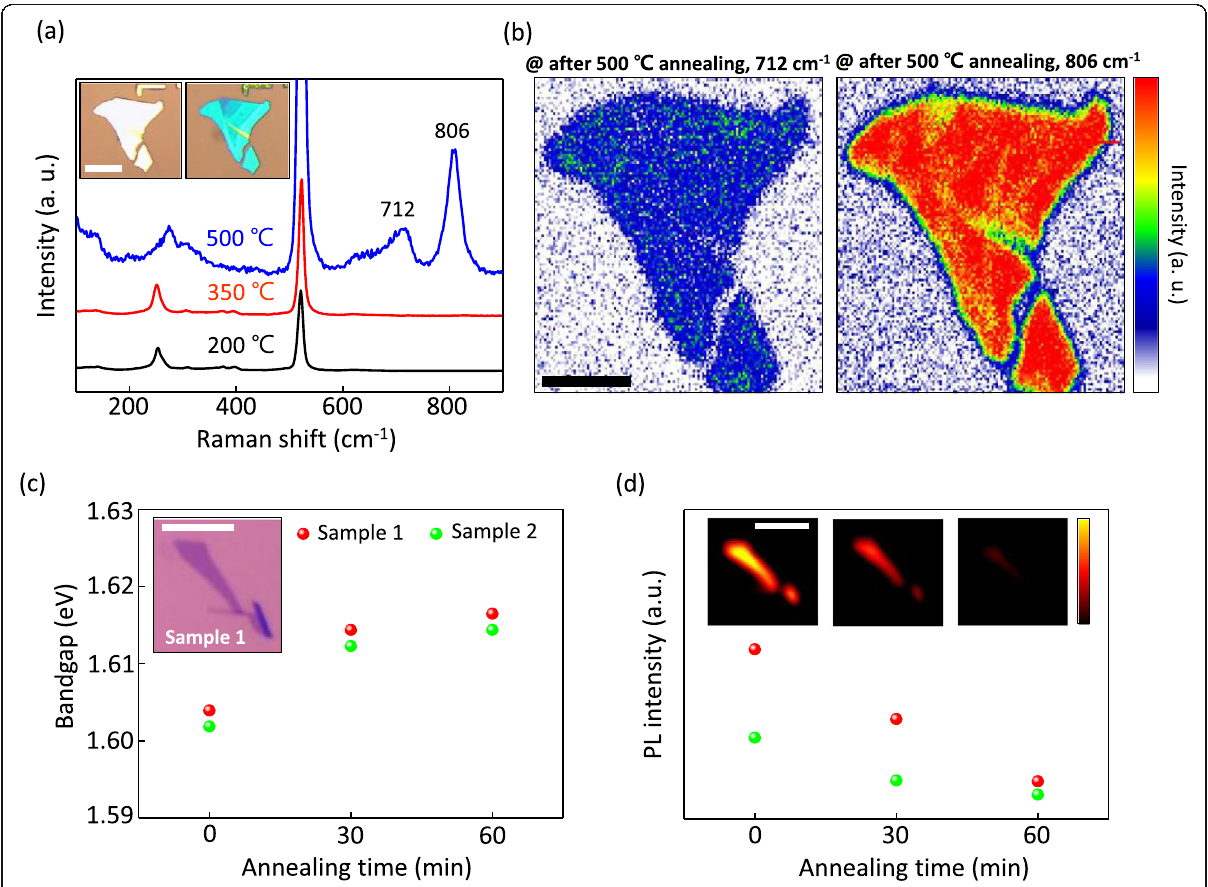
Fig. 6 a Raman spectra of the WSe 2 after annealing in ambient at 200 °C for 60 min (black line), at 350 °C for 60 min (red line), and at 500 °C for 5 min (blue line). Inset images correspond to the optical images before and after annealing in 500 °C, respectively. Scale bar = 15 μ m. b Raman mapping images after annealing at 500 °C integrating with bands at 712 cm − 1 and 806 cm − 1 , respectively. Scale bar = 10 μ m. c Optical bandgap of the WSe 2 before, after annealing in ambient at 250 °C for 30 min, and for 60 min. An inset image is the optical image of a monolayer WSe 2 flake (labeled as sample 1) with scale bar = 10 μ m. d Maximum PL intensity and corresponding PL mapping images with a scale bar of 10 μ